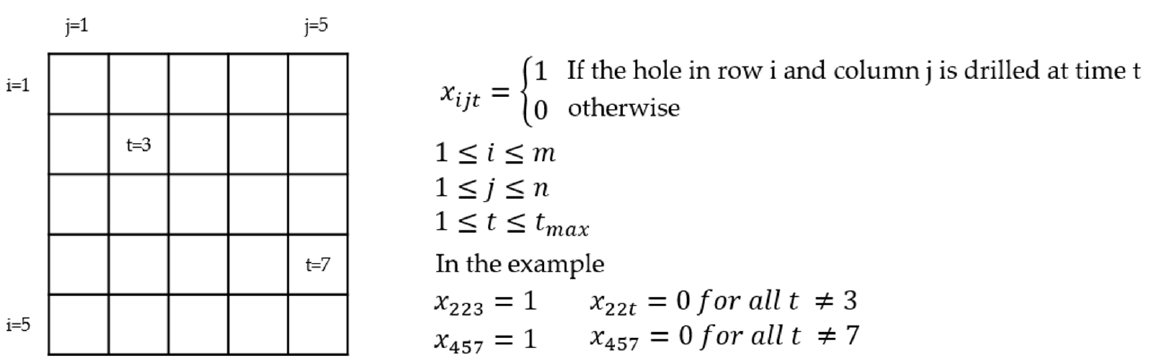
Figure 2. The schematic diagram for the explanation of the decision variables for the optimization problem.